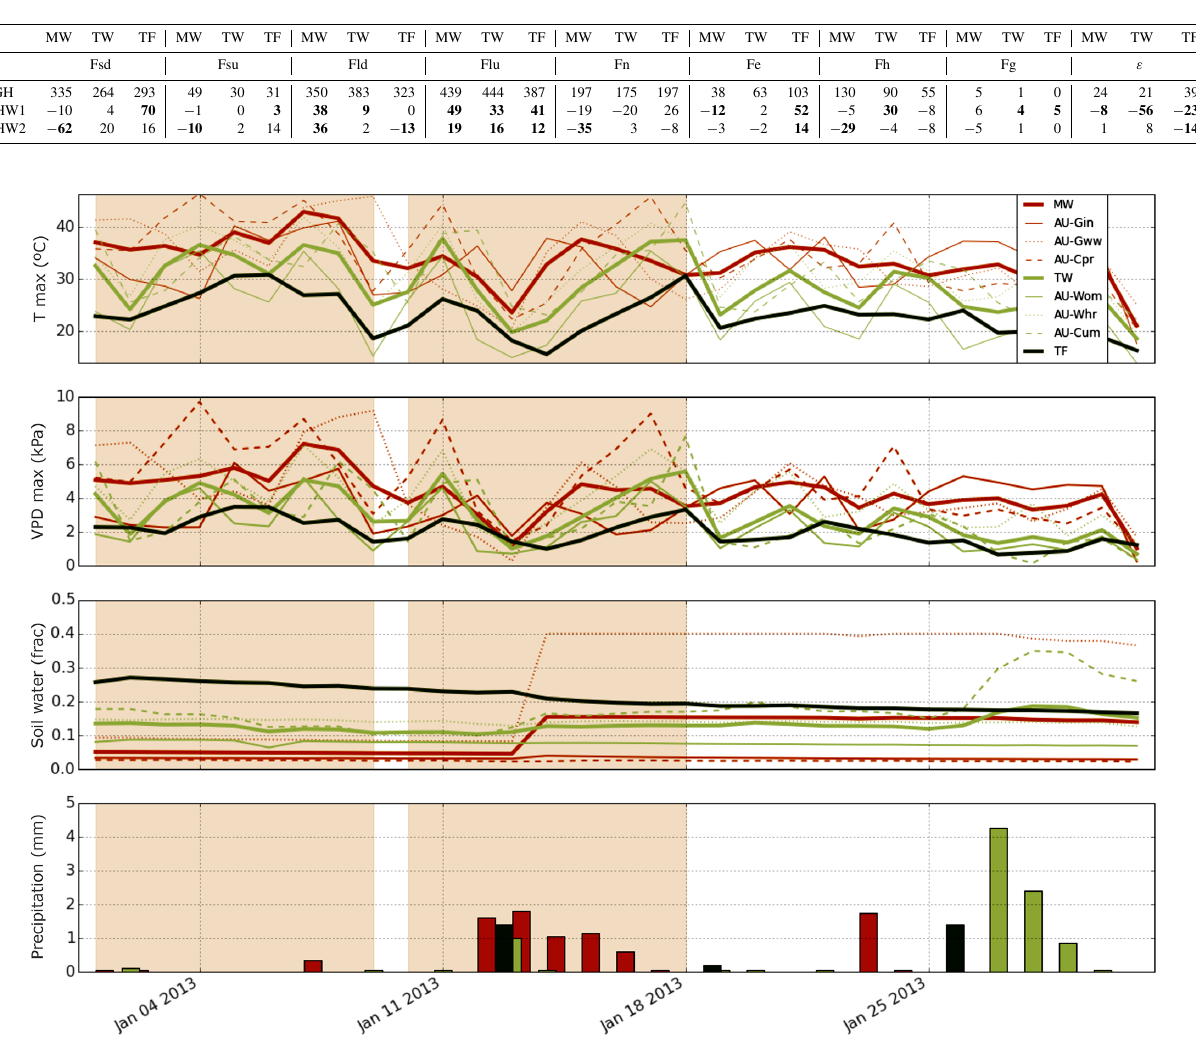
Figure 3. Time series of daily maximum temperature ( T max, top panel), daily maximum vapour pressure deficit (VPD max), soil water content and precipitation. The legend is given in the top panel. Precipitation ( P ) is given as the average of the daily accumulated precipitation of the sites and displayed for each biome. Shaded areas in the background indicate the time periods HW1 and